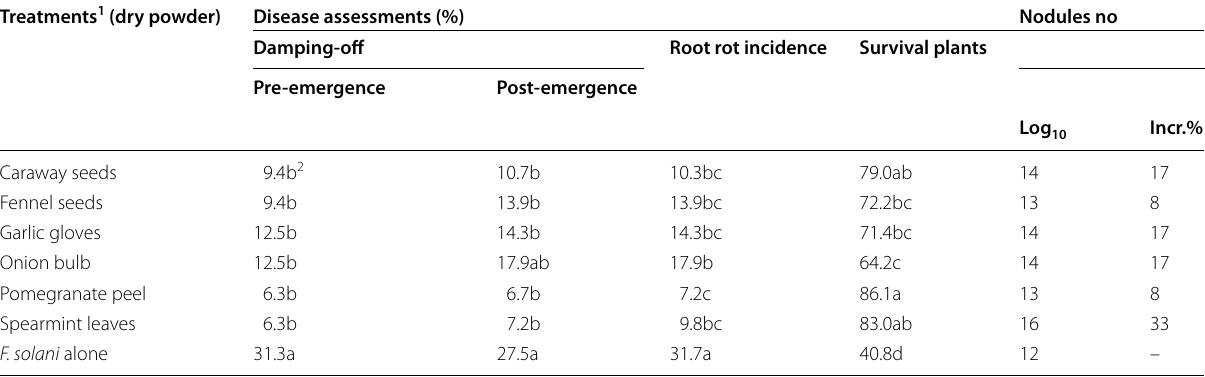
Table 1 Effect of dry powder plant materials on disease assessments of Fusarium solani as well as number of Rhizobium nodules in pea roots system in pots, under greenhouse